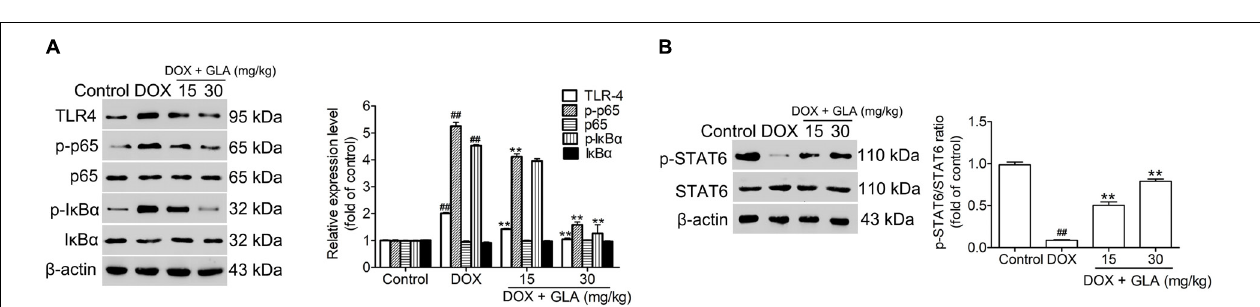
FIGURE 6 | Modulation of colonic macrophage phenotype by Glabridin (GLA) prevents doxorubicin (DOX)-induced cardiomyocyte apoptosis in mice. The C57BL/6 mice from the DOX (20 mg/kg) and GLA (30 mg/kg) groups were administrated intraperitoneally with the clodronate liposome (Clod) (100 mg/kg) 1 h after DOX injection, followed by repeated injections of 50 mg/kg every 4th day for 5 days. (A) Schematic representation of the experimental approach. (B) Representative images of the TUNEL assay ( n = 10). Scale bars, 20 µ m. (C) Quantitative result of TUNEL assay was analyzed ( n = 10). (D) Serum levels of AST, CK, CK-MB, and LDH were assessed ( n = 10). The values are presented as the mean ± SEM. ∗ P < 0.05, ∗∗ P < 0.01 vs. DOX, ˆ P < 0.05, ˆˆ P < 0.01 vs. DOX + GLA.